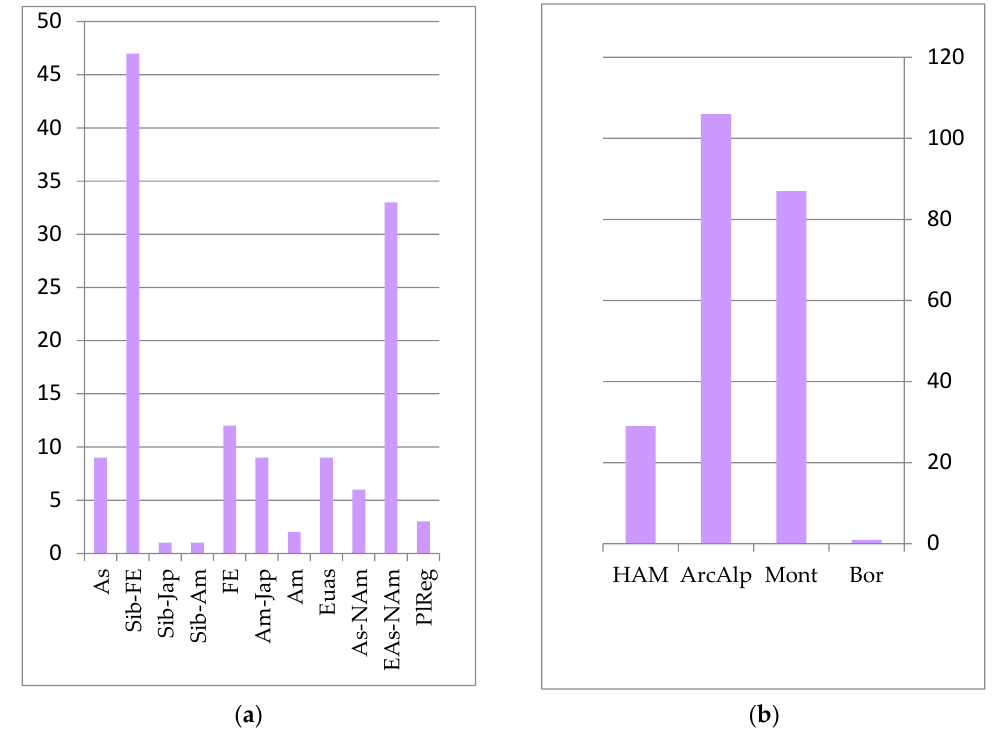
Figure 5. Number of species groups of the mountain tundra floristics complex: ( a ) longitudinal species groups: Asian (As); Siberian – Far Eastern (Sib-FE); Siberian – Japanese (Sib-Jap); Siberian – Amurense (Sib-Am); Far Eastern (FE); Amurense – Japanese (Am-Jap); Amurense (Am); Eurasian (Eas); Asian – North American (EAs-Nam); Eurasian – North American (Eas-NAm); PlReg – pluriregional; ( b ) zonal species groups: boreal (Bor); montane (Mont); arcto – alpine (ArcAlp); hypoarcto – montane (HAM).